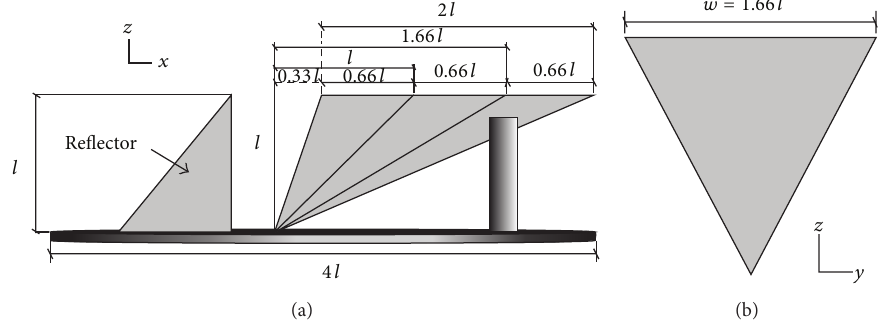
Figure 21: Lateral view of the proposed planar directional UWB antenna (a) and front view of the isosceles triangle (b).